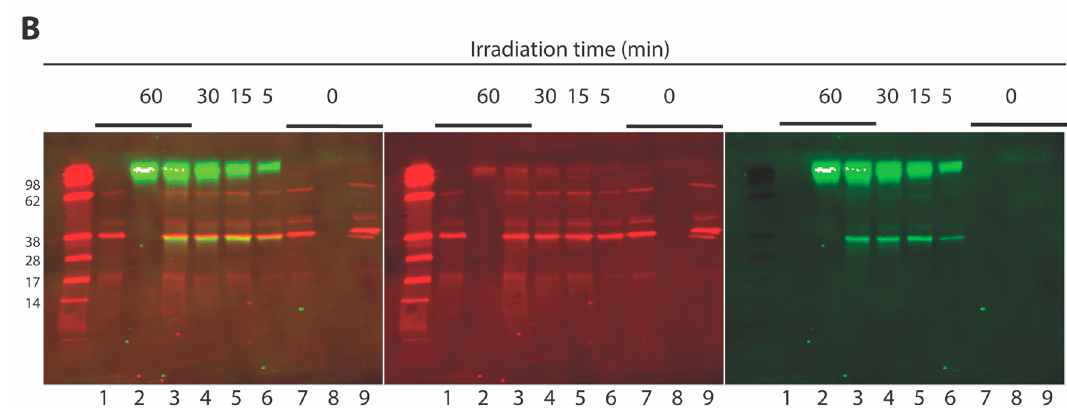
Figure 4. Integrase crosslinking studies. ( A ) Structure of photoprobe 15 showing inhibitory potencies in an in vitro IN assay. ( B ) Interaction of 15 with IN as evaluated by Western blotting after UV crosslinking (254 nM) and separation on Invitrogen Novex 4–20% Tris-Glycine gels (Invitrogen™ Novex™ SeeBlue™ Plus2 prestained protein standard is included in the outmost left lane): Lane 1, HIV-1 IN only (60 min UV); Lane 2, Peptide 15 only (60 min UV); Lane 3, IN and peptide 15 (60 min UV); Lane 4, 30 min UV; Lane 5, 15 min UV; Lane 6, 5 min UV; Lane 7, HIV-1 IN only; Lane 8, Peptide 15 only; Lane 9, IN and 15 . Gel stained with rabbit anti-IN CTD polyclonal (260–280)/anti-rabbit Licor, 680 nm (center, red), streptavidine-AlexaFluor 750 nm (right, green), merged image (left, merged). Molecular size markers are indicated at left (kDa).